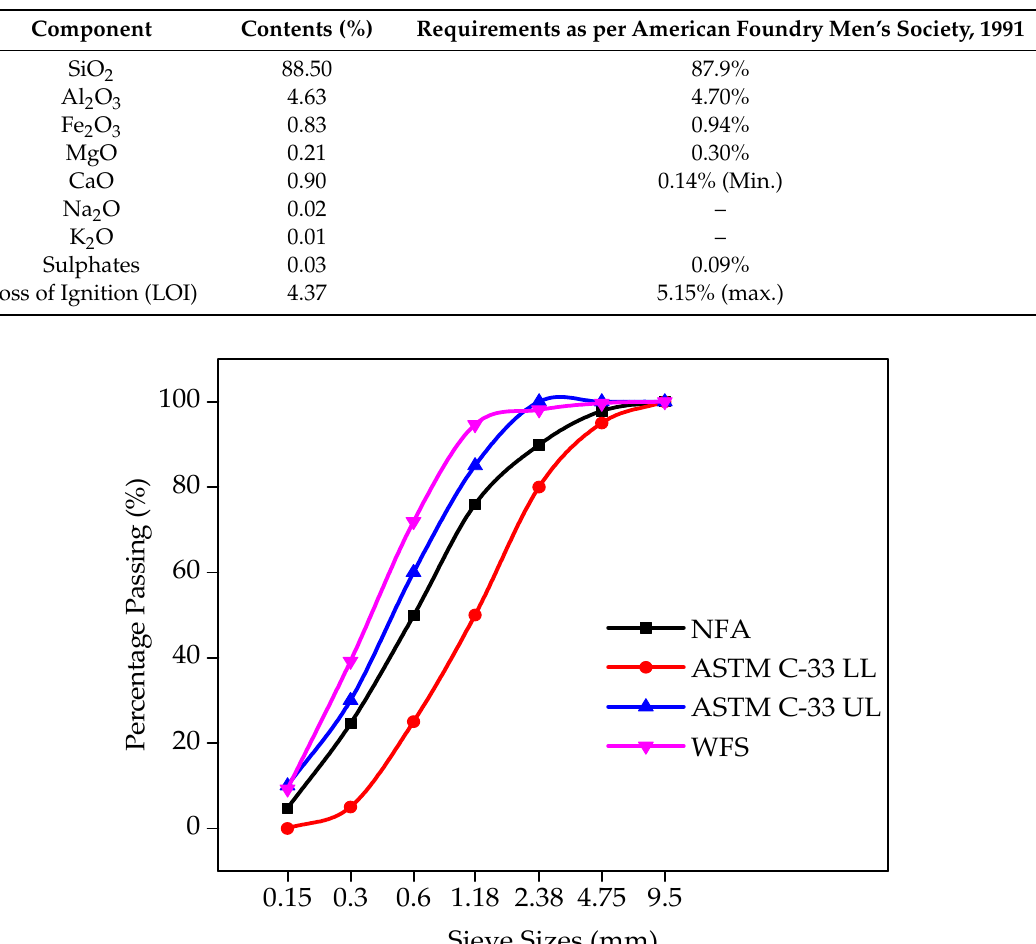
Figure 1. Sieve analysis results of natural fine aggregate (NFA) and waste foundry sand (WFS) in line with ASTM C-33 limits.